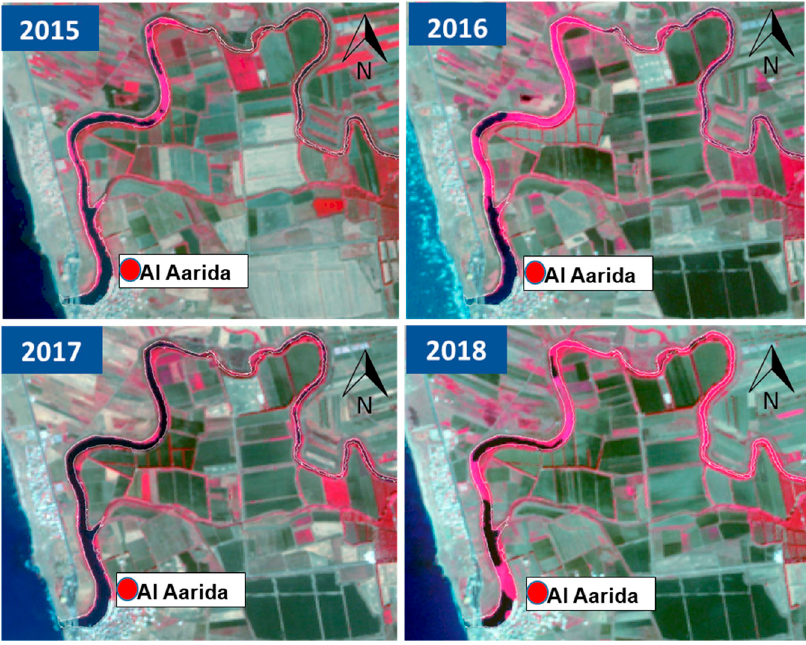
Figure 11. Sentinel-2 images from September of 2015–2018 at the Al Aarida site. Magenta areas on the river represent water hyacinth cover.